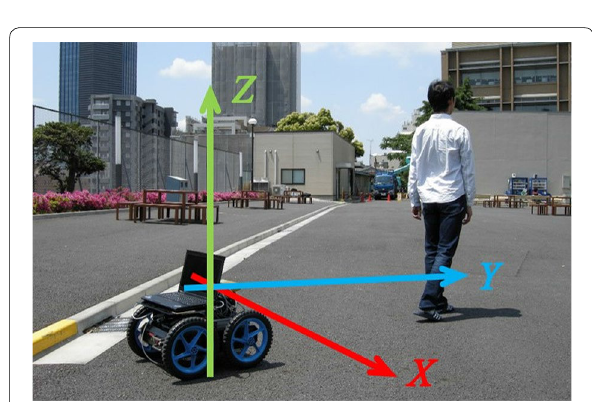
Fig. 2 X–Y–Z coordinate of the proposed